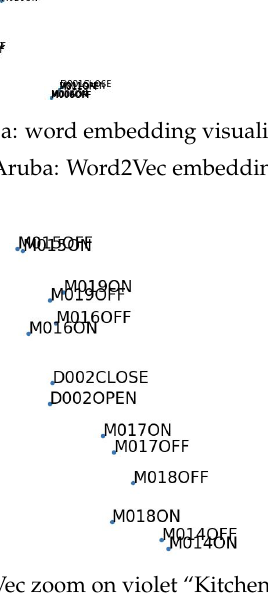
Figure 6. Cluster